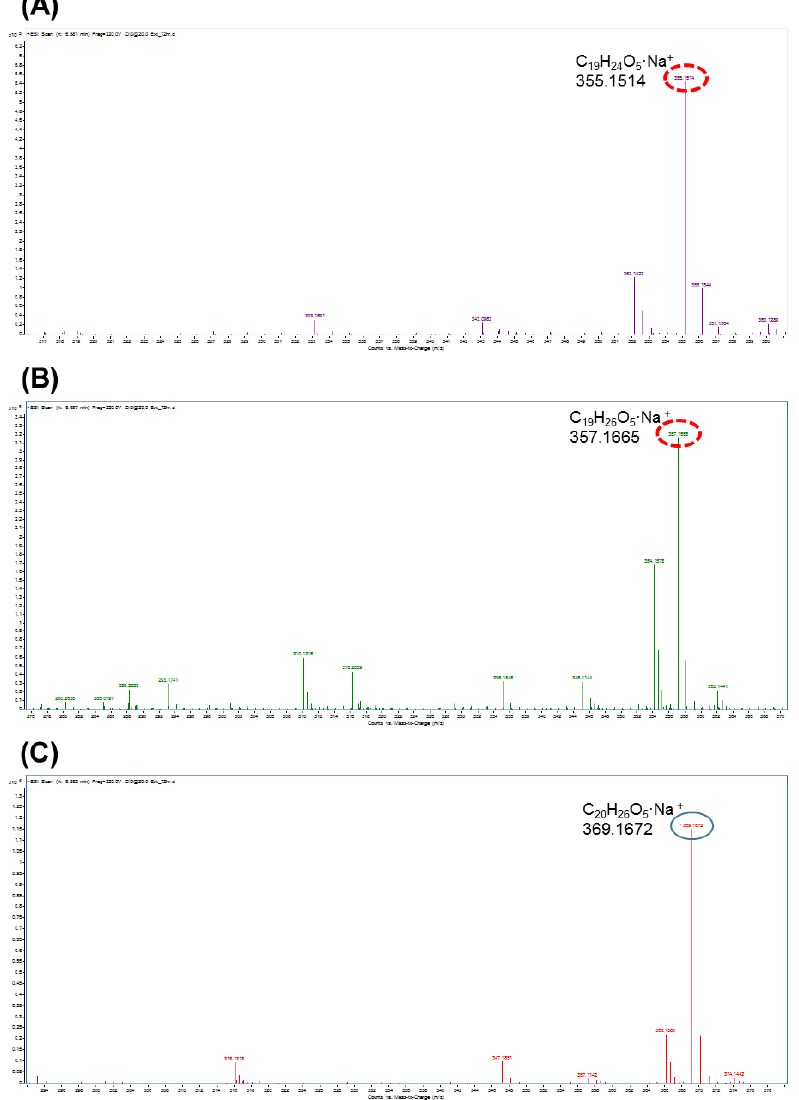
Figure 3. LC-Q-TOF mass spectrum of ( A ) arnicolide D, ( B ) arnicolide C, and ( C ) microhelenin C in CMX. CMX, emulsion extract of brevilin A from Centipeda minima ; LC-Q-TOF, liquid chromatography-quadrupole-time of flight.